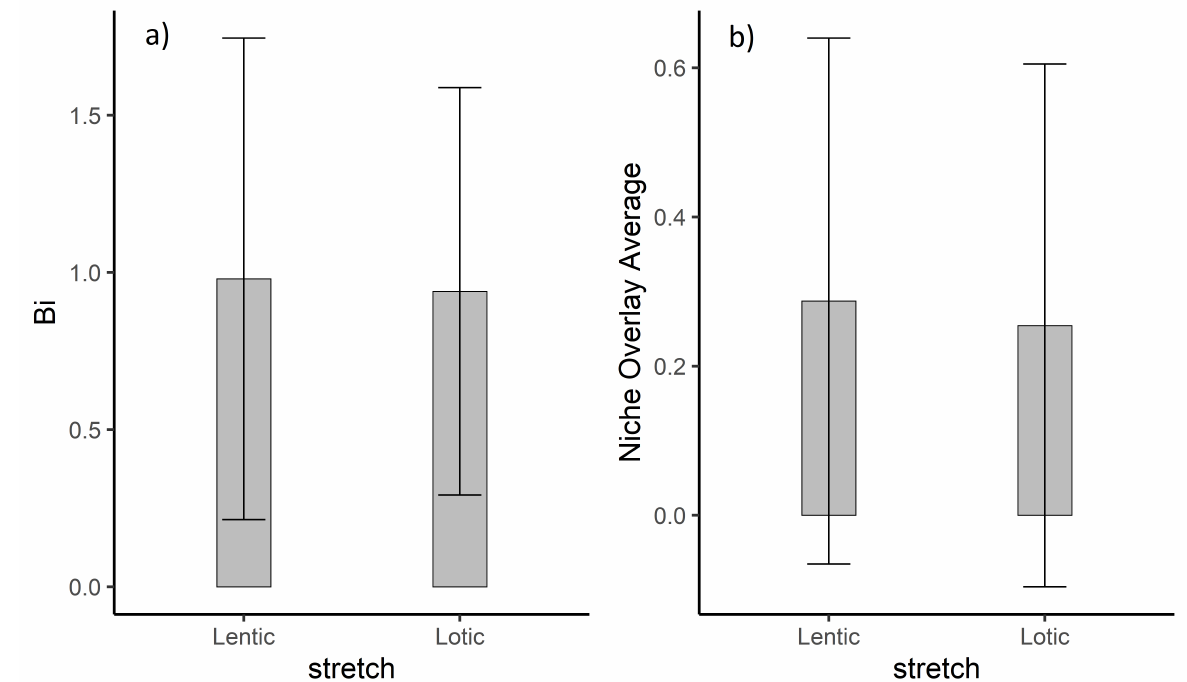
Figure 3. a) Trophic niche breadth and b) trophic niche overlap of fish species in each stretch of the Chavantes Reservoir, middle Paranapanema river